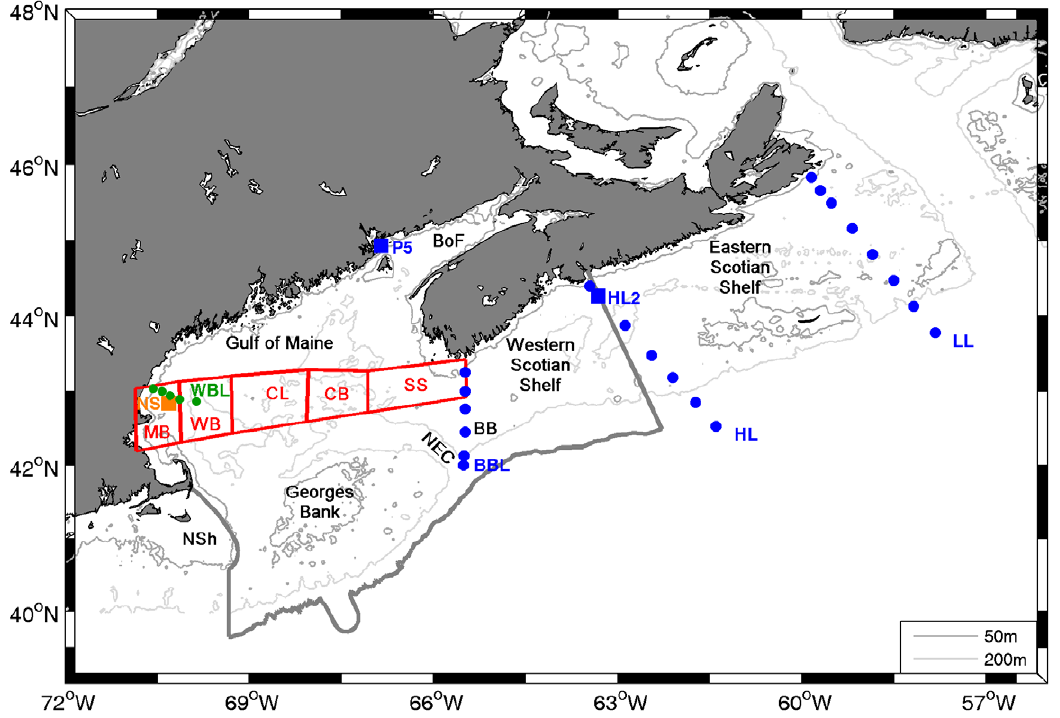
Figure 1. Gulf of Maine and Scotian Shelf, including areas sampled. Gray line indicates the boundary of the Gulf of Maine Area. Red boxes are regions sampled with the Continuous Plankton Recorder, and circles and squares are stations sampled with plankton nets. AZMP stations are indicated by blue symbols, COOA stations by green symbols, and PULSE by an orange symbol. BB – Browns Bank; BBL - Browns Bank Line; BoF - Bay of Fundy; CB - Crowell Basin; CL - Cashes Ledge; HL - Halifax Line; HL2 - Halifax line station 2; LL - Louisbourg Line; MB - Massachusetts Bay; NEC – Northeast Channel; NS - New Scantum (Jeffreys Ledge); NSh – Nantucket Shoals; P5 – Prince-5; SS - Scotian Shelf inflow; WB - Wilkinson Basin; WBL - Wilkinson Basin Line.